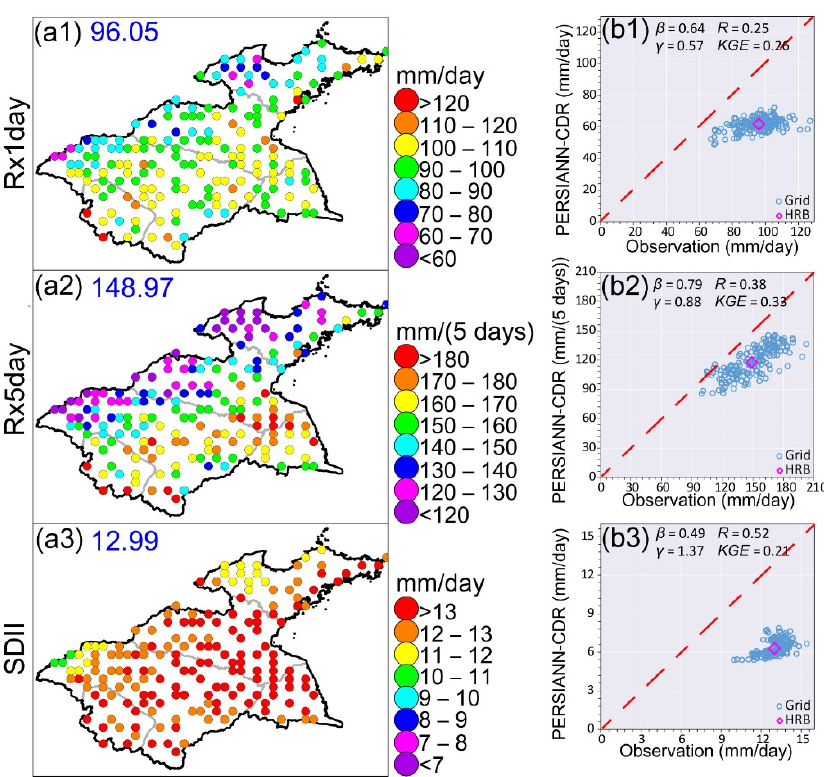
Figure 11. Spatial patterns of multi-year annual means of the observational intensity-based indices and the scatterplots between observation and PERSIANN-CDR. a1 – a3 ( b1 – b3 ) are for Rx1day, Rx5day, and SDII, respectively. In a1 – a3 , the blue numbers represent the HRB mean for a given extreme precipitation index. The red dashed line in b1 – b3 is the 1:1 line.